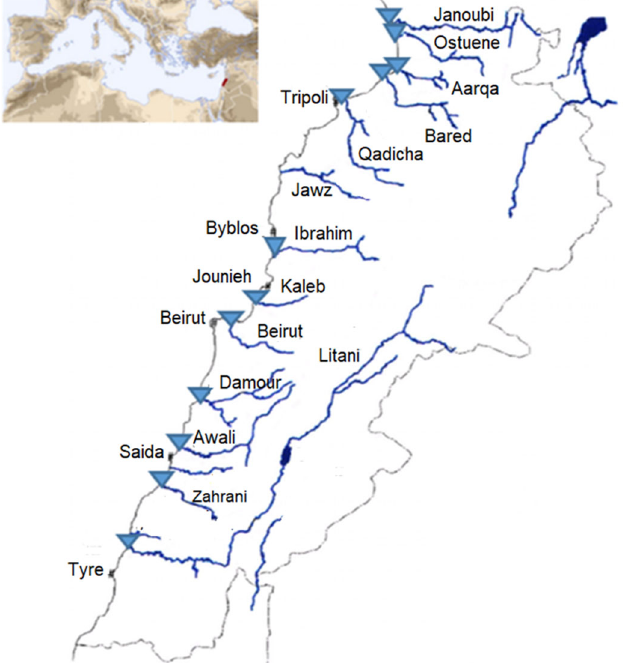
Figure 5. Sampling sites are represented as blue triangles on the map of the Lebanese rivers. Figure adapted from Houri and El Jeblawi (2007).